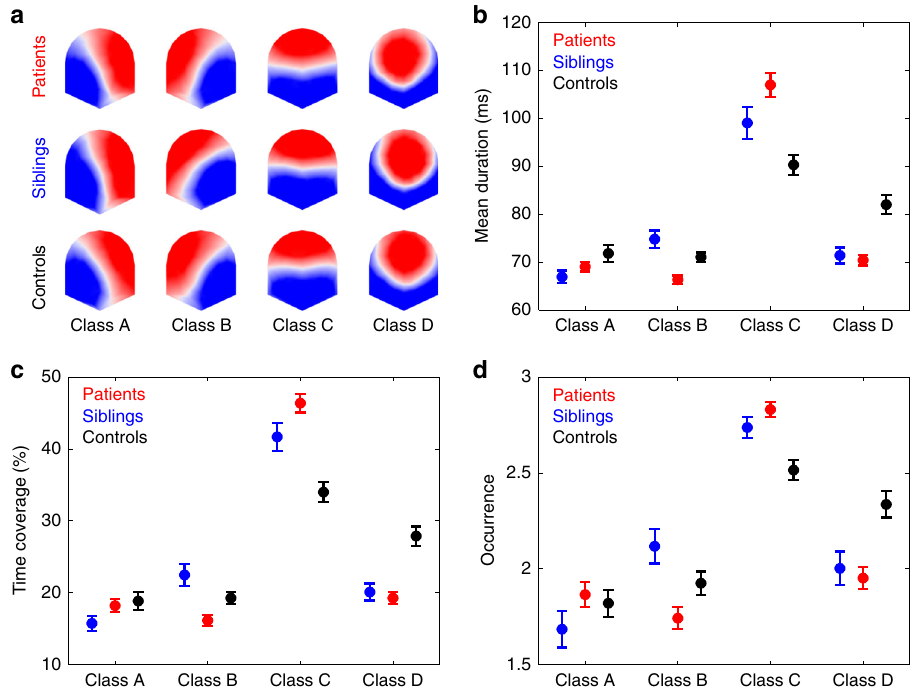
Fig. 1 Results of the microstate analysis for study 1. Patients data are displayed in red ( n = 101), siblings in blue ( n = 43), and controls in black ( n = 75). a The spatial con fi guration of the four microstate classes (A, B, C, and D) for the three groups. Group average statistics of the temporal microstate parameters: b mean duration, c time coverage, and d occurrence. For patients vs. controls, since groups differed in education and gender, for each microstate parameter, we computed a repeated measured (rm)-ANOVA with Group, Microstate Class, and Gender as factors and Education as covariate. Following signi fi cant Group × Microstate Class interactions, we performed post hoc group comparisons (Table 1). For siblings vs. controls, for each